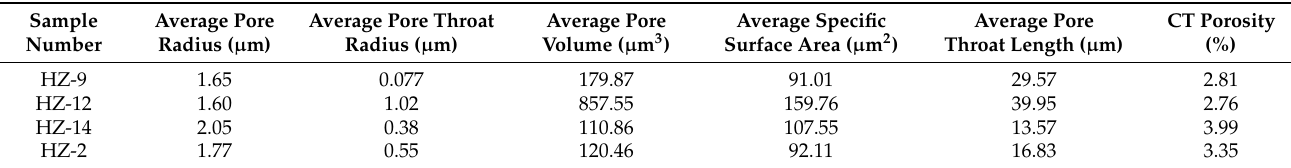
Figure 11. Face rate variation of the carbonate rock samples in the Huize lead–zinc deposit. Table 6. Pore throat structure parameters of the carbonate rock samples in the Huize lead–zinc